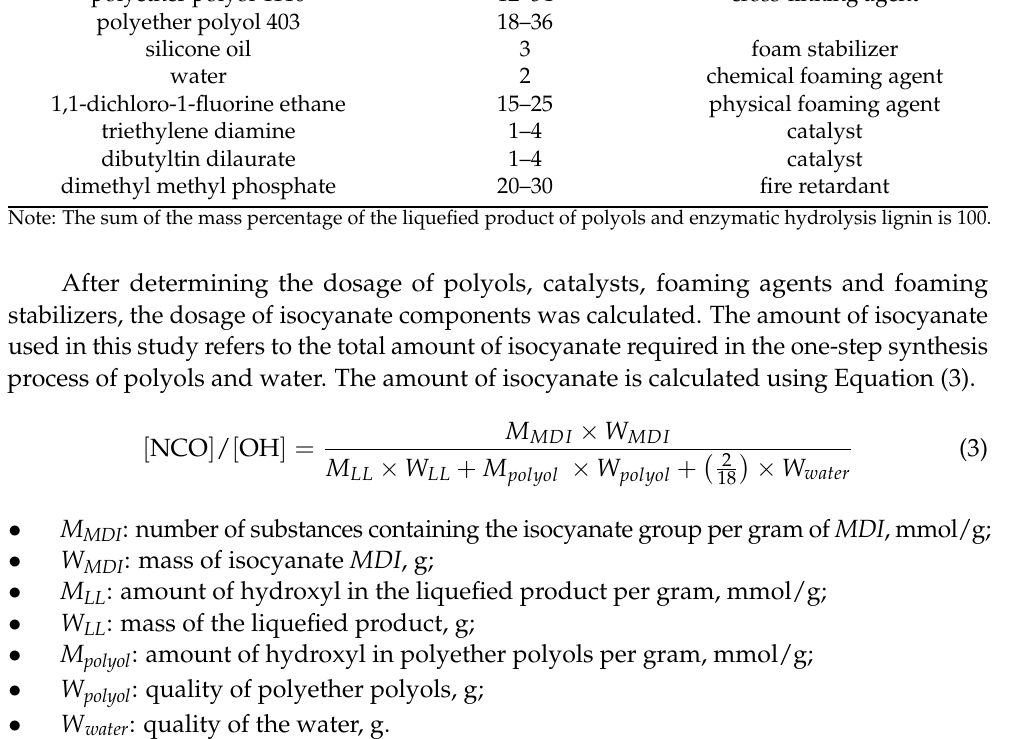
Table 1. Formulation of liquefied wood-powder-based polyurethane foaming material. Component Mass Percent % Roles Wood-powder-based polyols (20 g) 10–70 polyether polyol 4110 12–54 cross-linking agent polyether polyol